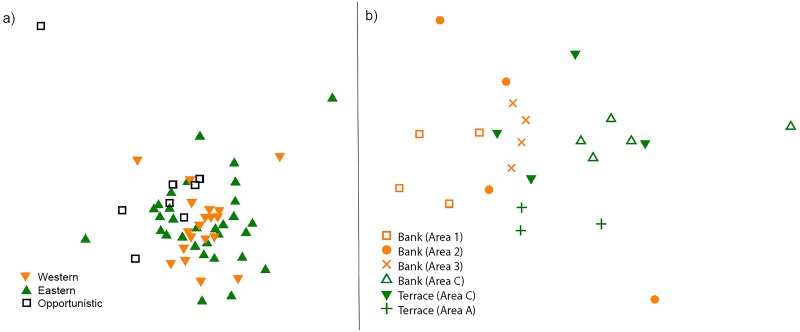
Non metric multidimensional scaling (n-MDS) plots using Bray-Curtis similarities for sponge assemblages in which singletons were excluded, showing collected from a) all raised geomorphic features, excluding an outlier at Station 63 from SOL4934 at which only one non-singleton species was collected (stress = 0.16) and b) raised geomorphic features at which sponges were collected from three or more sites in the western CMR (orange, numeric codes) and eastern CMR (green, alphabetic codes) stress = (0.014).Locations of each geomorphic feature are shown in Fig 1. Each point on an MDS represents an assemblage collected at a site, and increasing distance between points indicates decreasing similarity.